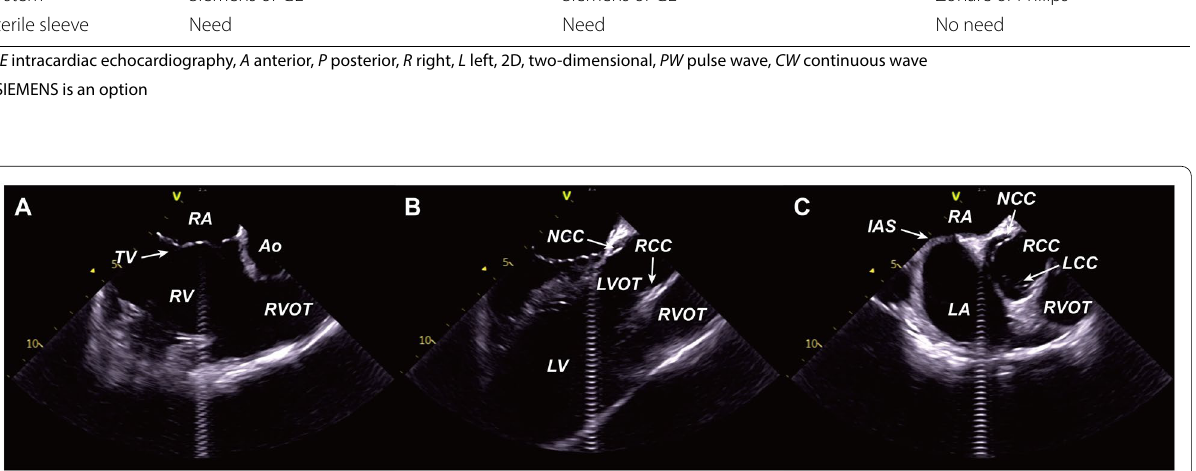
Fig. 1 Assessment of the ventricular outflow tracts from the right atrium. A. Home view. B. RVOT and LVOT view. C. Aortic valve short‑axis view in RA. RVOT, right ventricular outflow tract; LVOT, left ventricular outflow tract; RA, right atrium; RV, right ventricle; TV, tricuspid valve; Ao, aortic root; RCC; right coronary cusp; LCC; left coronary cusp; NCC, non‑coronary cusp; LV, left ventricle; IAS, interatrial septum; LA, left